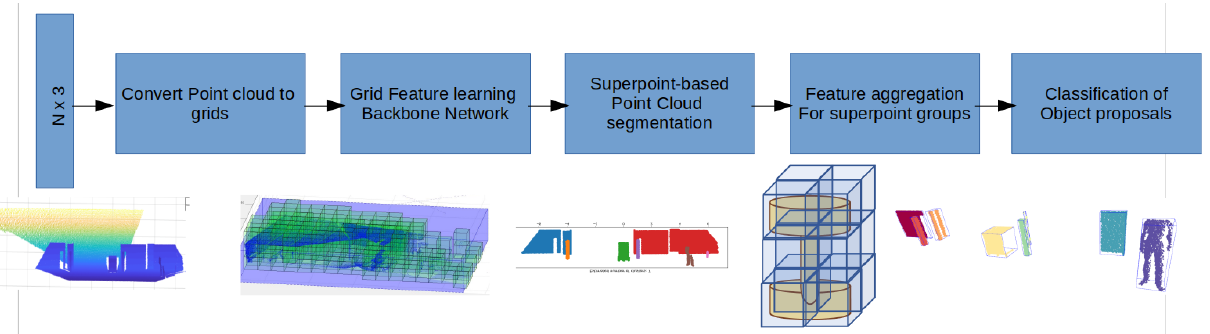
Figure 1. Architecture of the proposed method illustrating object detection